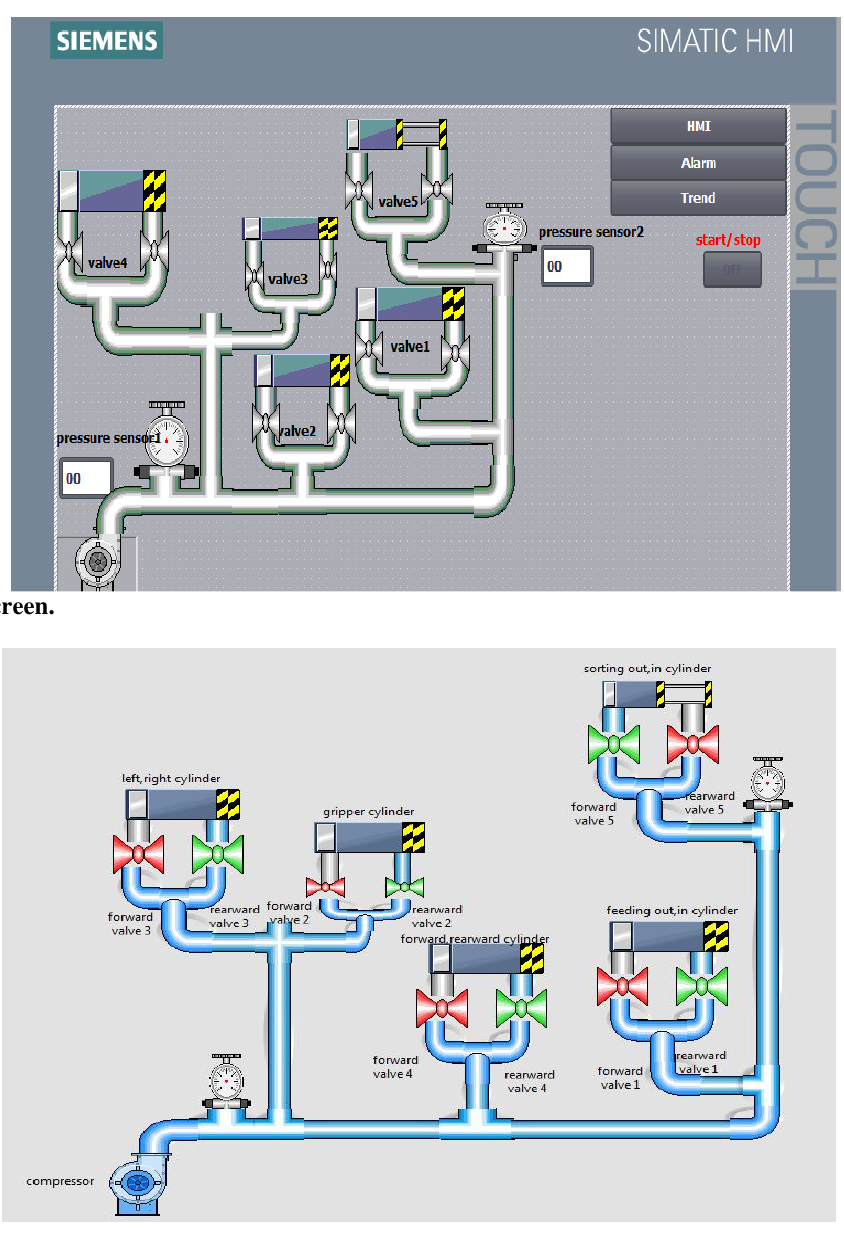
Fig. 19. Two HMI result sorting cylinder